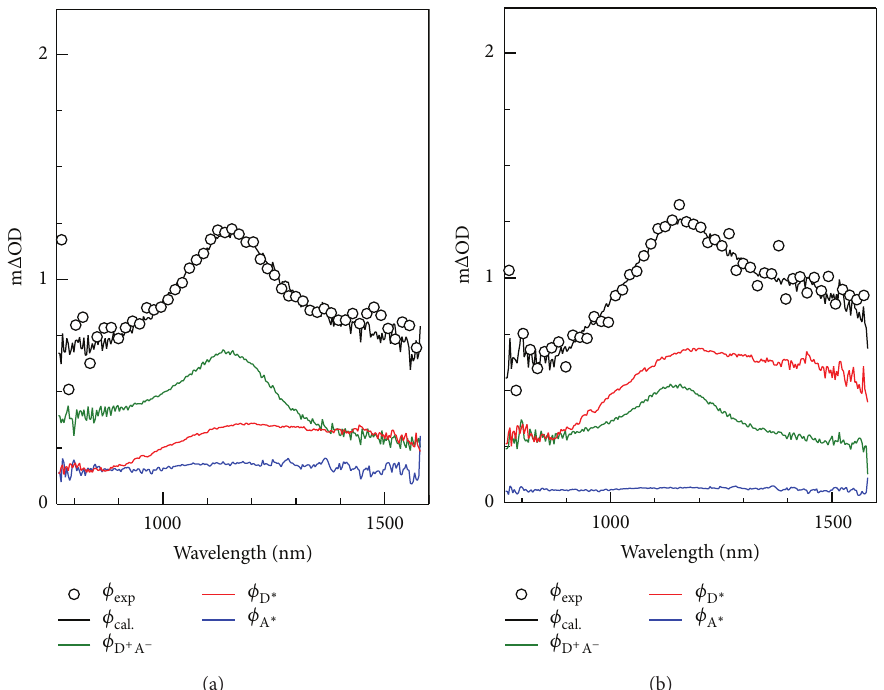
Figure 13: Δ OD spectra of PTB7/C 70 bilayer film at 0.9 ps at (a) 300K and (b) 80K. Solid curves are results of the decomposition into 𝜙 D + A − , 𝜙 𝜙 A ∗ , and D ∗ .